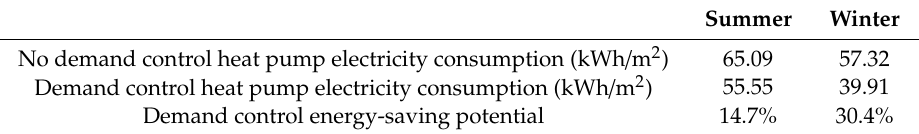
Figure 30. The electricity consumption of each room with/without demand control in winter. Table 5. Total electricity consumption of the house and demand-control energy-saving percentages.